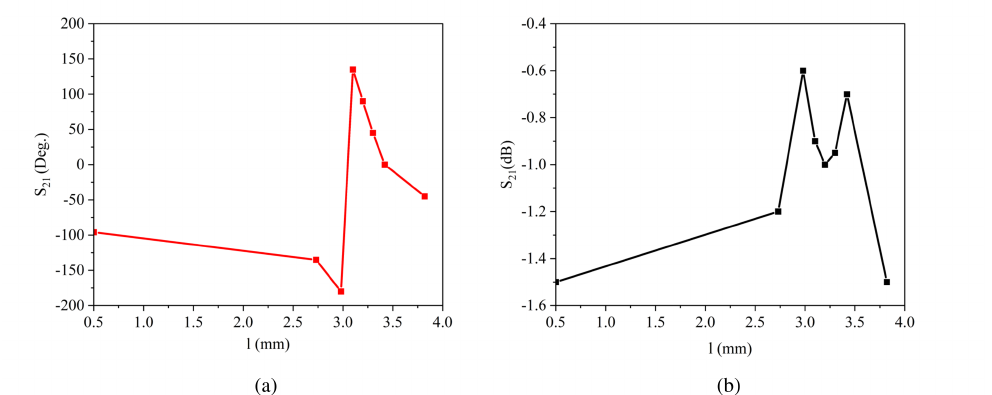
Figure 2. ( a ) Phase response, and ( b ) amplitude response of the unit cell according to different values for l ( l + g = 4.4